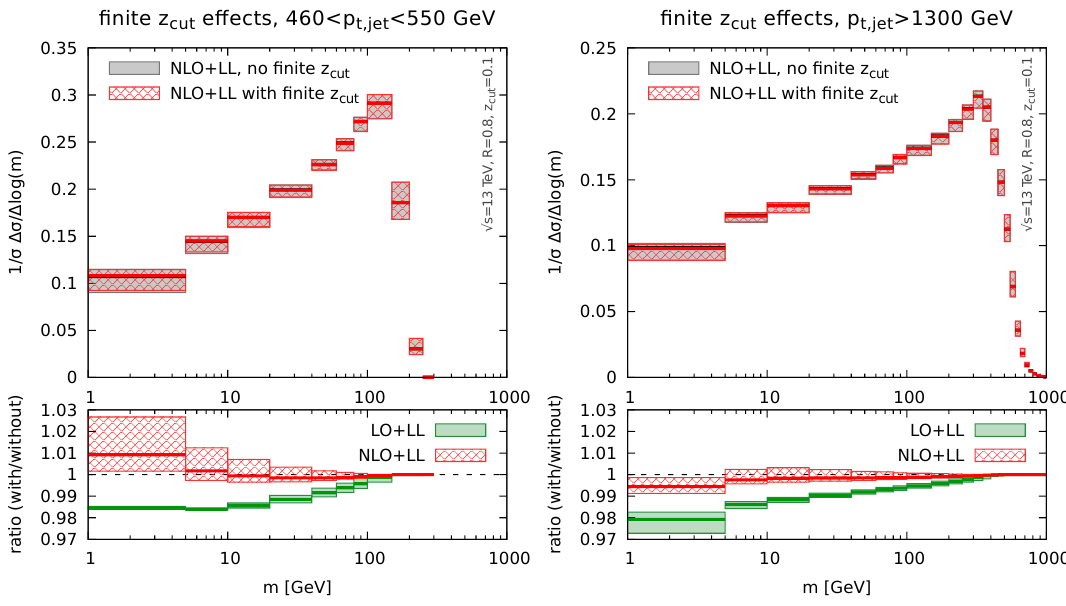
Figure 3 . Comparison between the resummed and matched calculation with (cid:12)nite z cut (red) and the result with the resummation computed in the z cut ! 0 limit. The ratio plots at the bottom show that for z cut = 0 : 1 this type of correction is very small.